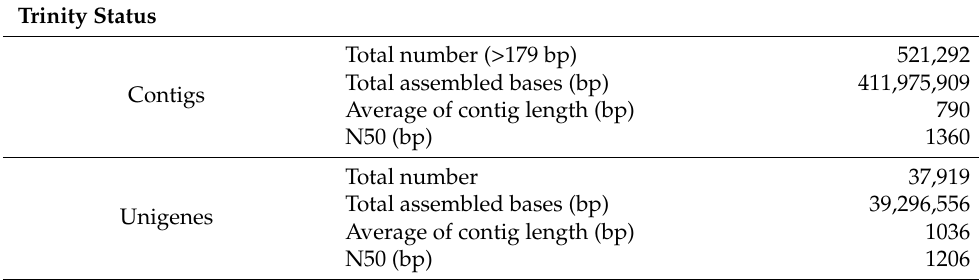
Table 1. Outline of the results of RNA-seq